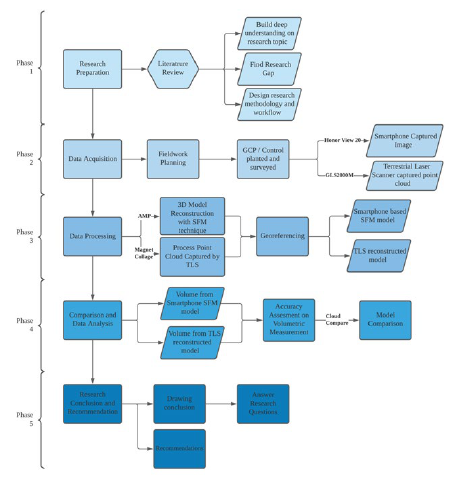
Figure 3.1. Research Methodology